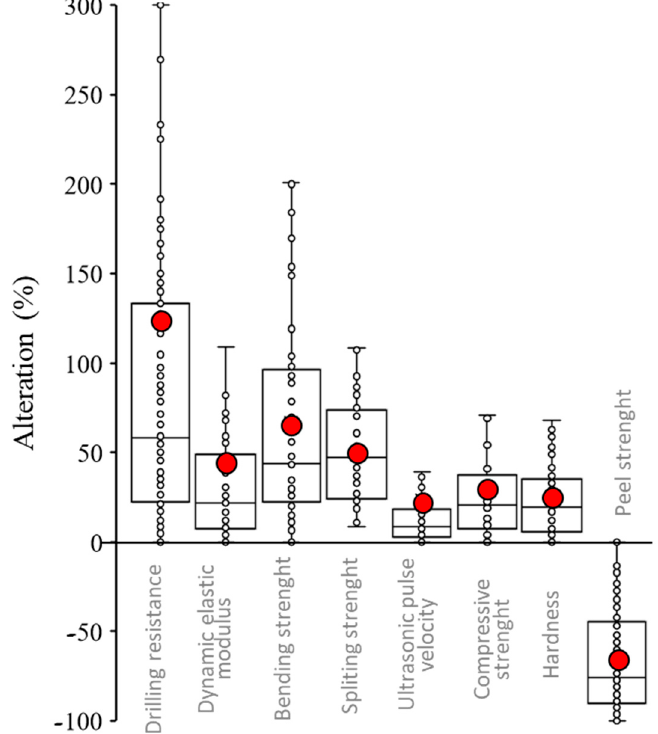
Figure 7. Statistics on the strengthening values (alteration) reported by the articles included in the database for the consolidation treatments. The data are grouped according to the assessment techniques used. (Lower limit: 1st quartile; upper limit: 3rd quartile; black line: media; red dot: average; outliers not represented).